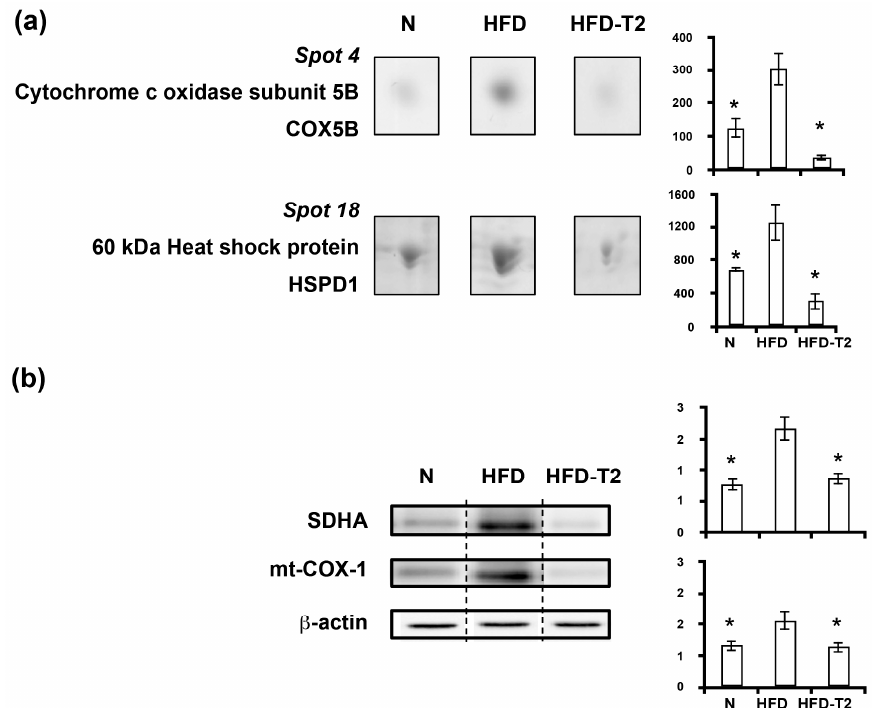
Figure 7. Four-week 3,5-T2 treatment-associated differential representation within the VAT proteome with regard to mitochondrial proteins. ( a ) Representative subsections of 2D-E images of VAT of N, HFD, HFD-T2 rats. Results are expressed as arbitrary units (means ± SEM; n = 4) ( p < 0.05). Spot numbering refers to Figure 5a. ( b ) Representative immunoblot analysis of succinate dehydrogenase complex subunit A (SDHA) and mitochondrially-encoded cytochrome c oxidase I (mt-COX-1) protein levels in N, HFD, and HFD-T2 rats. Protein levels were normalized to β -actin. Protein load was 30 µg/lane. The vertical dotted lines indicate cuts in the membrane. Data were normalized to the value obtained for N animals (set as 1). Shown are the mean values ± SEM ( n = 4). * p < 0.05 vs. HFD.